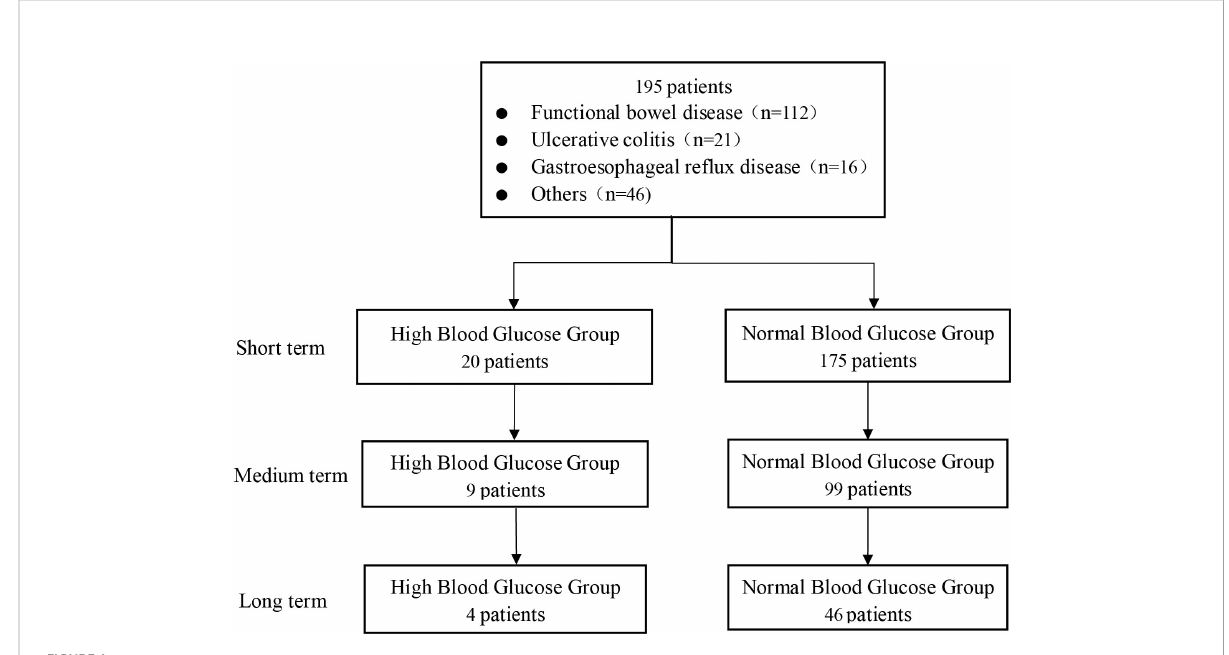
FIGURE 1 Flow chart of this